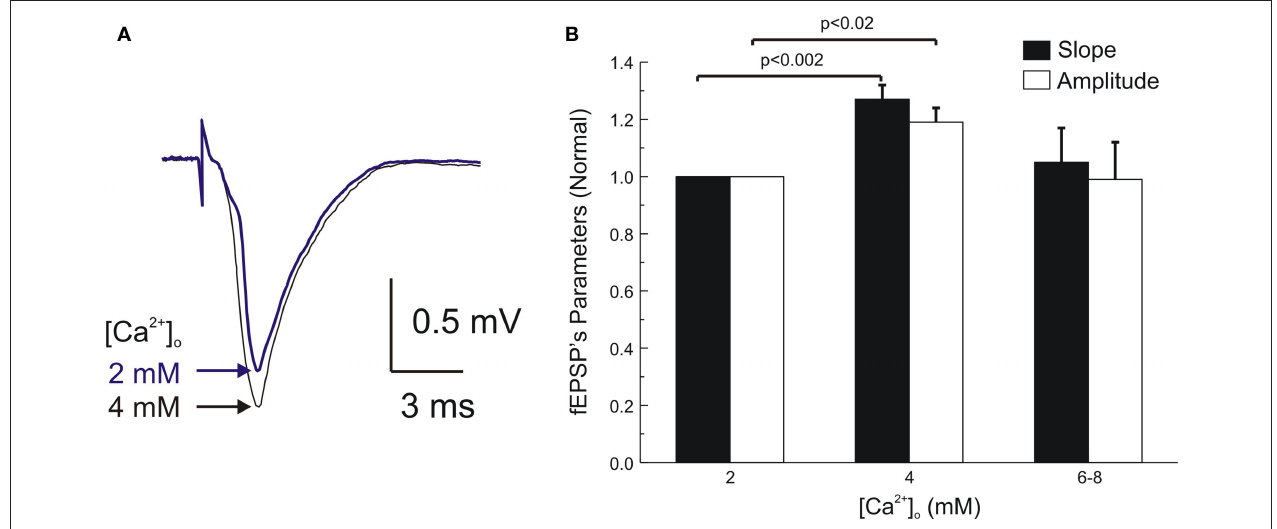
Figure 1 | enhancement of single MPP fePSP’s by elevated [Ca 2 + ] normobaric conditions. (A) fEPSPs recorded at the inner dendritic area of the dentate gyrus at [Ca 2 + ] 2 and 4 mM. (B) Statistical analysis of single fEPSPs o amplitudes and slopes under 2, 4, ( n = 6) and 6–8 mM [Ca 2 + ]